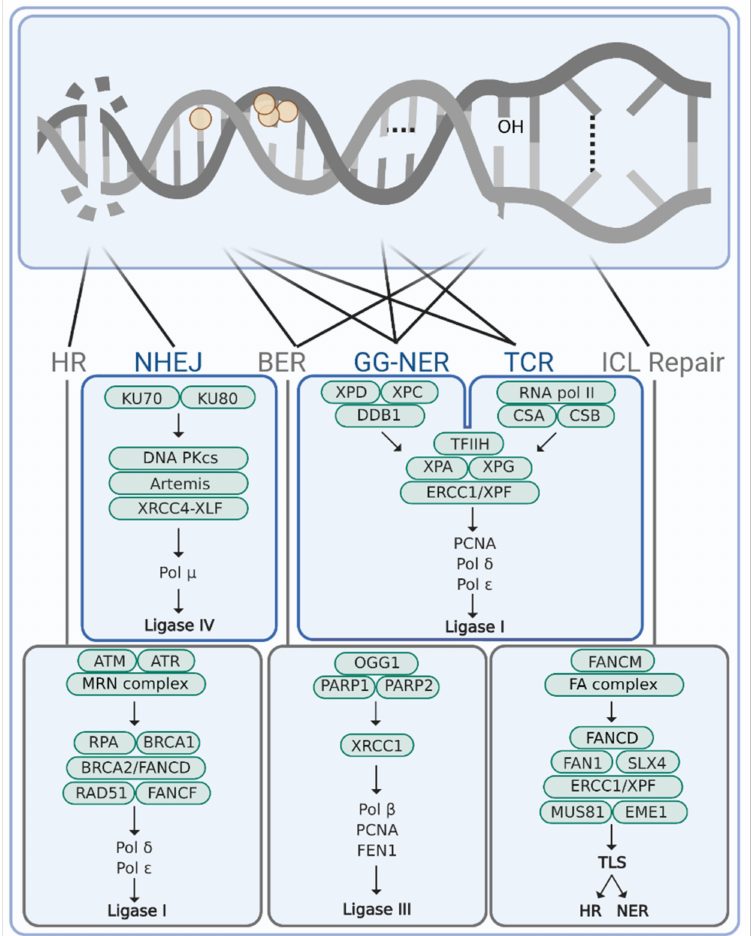
Figure 2. DNA damage repair mechanisms involved in repair of DNA lesions commonly caused by chemotherapeutics. Schematic representations of, from left to right, double-strand break, DNA alkylation, bulky adduct, intrastrand crosslink, DNA oxidation, and interstrand crosslink. DNA repair pathways responsible for the removal of the represented DNA lesions are schematically shown below with the key proteins involved in the depicted DNA repair processes. HR, homologous recombination; NHEJ, non-homologous end joining; BER, base excision repair; GG-NER, global genome-nucleotide excision repair; TCR, transcription-coupled repair; ICL, interstrand crosslink repair (during replication); TLS, translesion